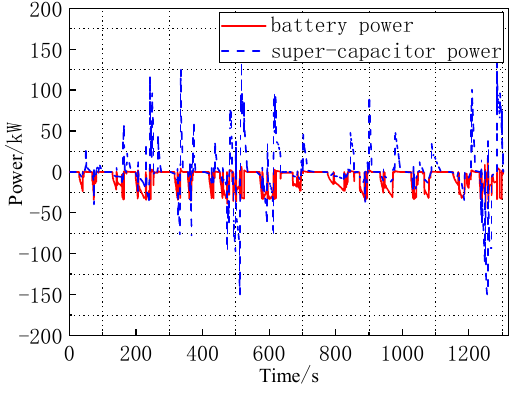
Figure 15. HESS current when using fuzzy control.